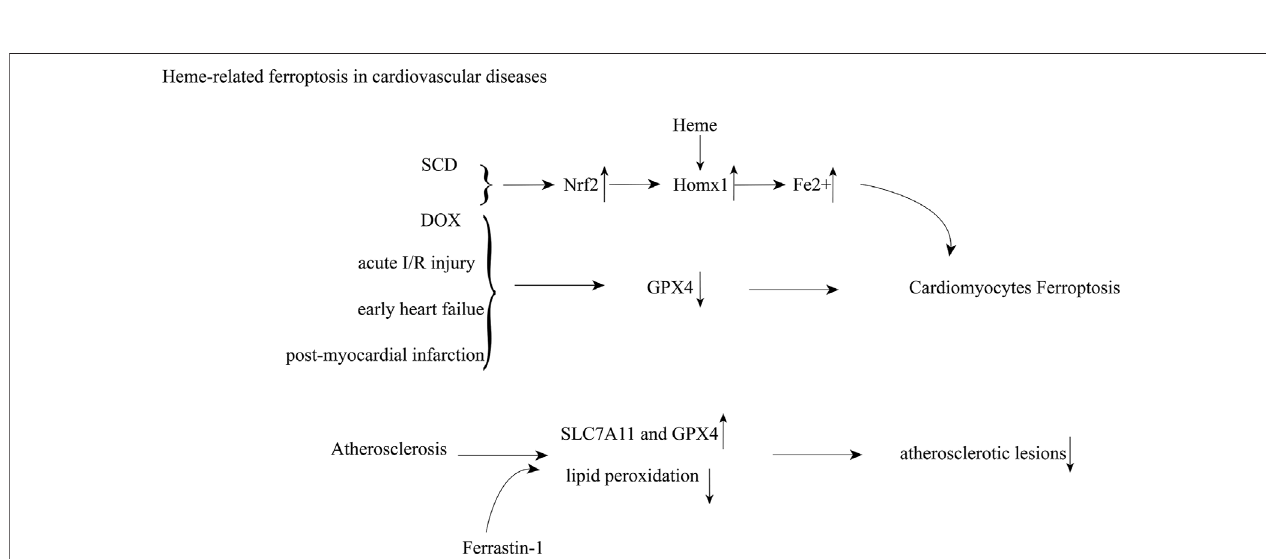
FIGURE 2 | Heme-induced cardiovascular damage through ferroptosis; Abbreviations: sickle cell disease (SCD); doxorubicin (DOX); nuclear factor erythroid 2- related factor 2 (Nrf2); heme oxygenase 1 (Homx1); glutathione peroxidase 4 (GPX4); ischemia-reperfusion (I/R).